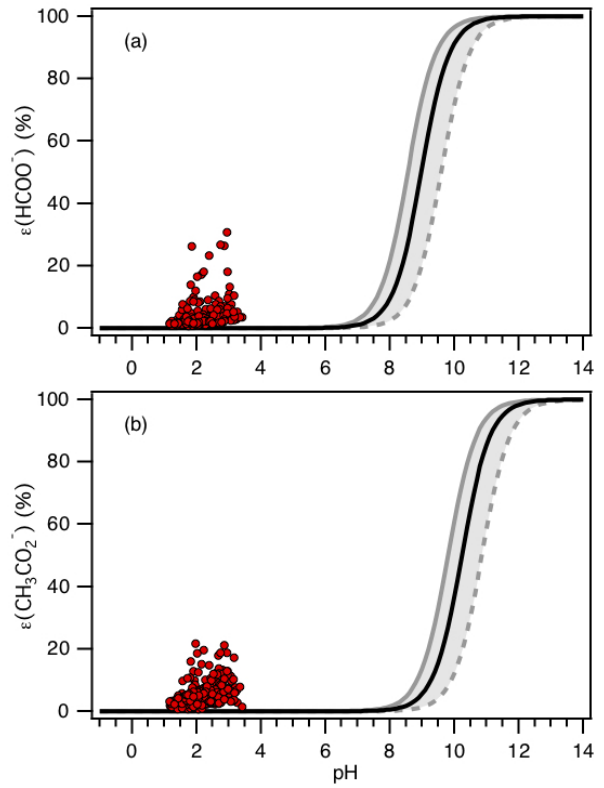
Figure 8. Analytically calculated S curves of ε (HCOO − ) and ε (CH 3 CO − ) (solid black lines) and ambient data from 13 Septem- 2 ber to 6 October 2016 plotted against ISORROPIA-predicted particle pH (shown in a and b , respectively). For the ambi- ent data, a narrow range in W i (0.5 to 4µgm − 3 ) and RH (20% to 90%) is chosen to be close to the analytically cal- culated outputs. For the analytically calculated S curves, we = 2 . 150 (AIOMFAC pre- used γ HCOOH = 0 . 334 and γ CH 3 COOH = = γ dicted). We also assumed that γ H + γ H + γ CH 3 COO − HCOO − = γ H + γ and used the ISORROPIA-predicted γ NO − 3 H + − NO − 3 q γ = 0 . 265. The black lines are S curves calculated using H + γ NO − 3 the selected time period’s average temperature (23 . 4 ± 4 . 0 ◦ C) and W i (1 . 6 ± 1 . 7µgm − 3 ). The grey lines are S curves calculated using 1 standard deviation from the average temperature and W i (i.e., tem- perature = 27.4 ◦ C and W i = 0 . 5µgm − 3 for dotted grey line; tem- perature = 19.4 ◦ C and W i = 3 . 3µgm − 3 for solid grey